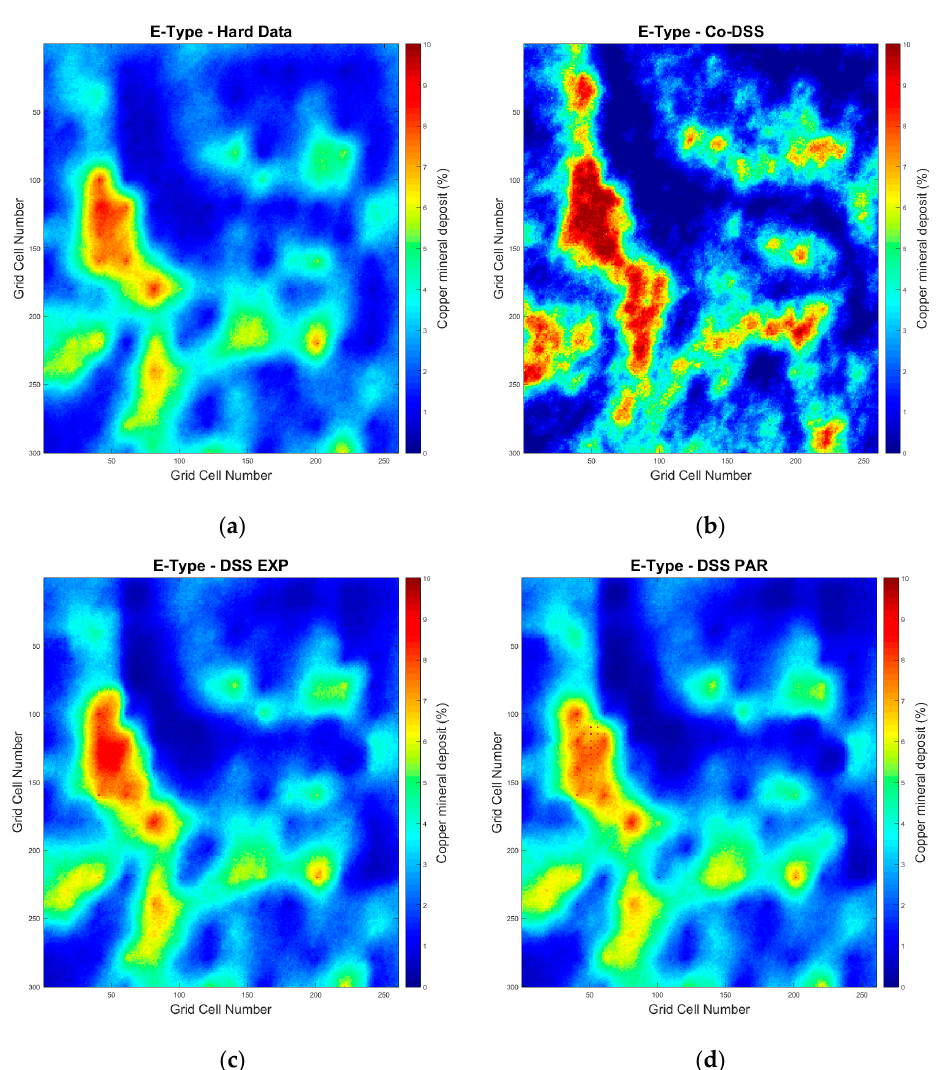
Figure 4. E-type of the 100 simulations generated for each simulation strategy used: ( a ) direct sequential simulation with only hard data, ( b ) direct sequential collocated co-simulation, ( c ) direct sequential simulation with experimental point distributions, and ( d ) direct sequential simulation with parameterized point distributions.